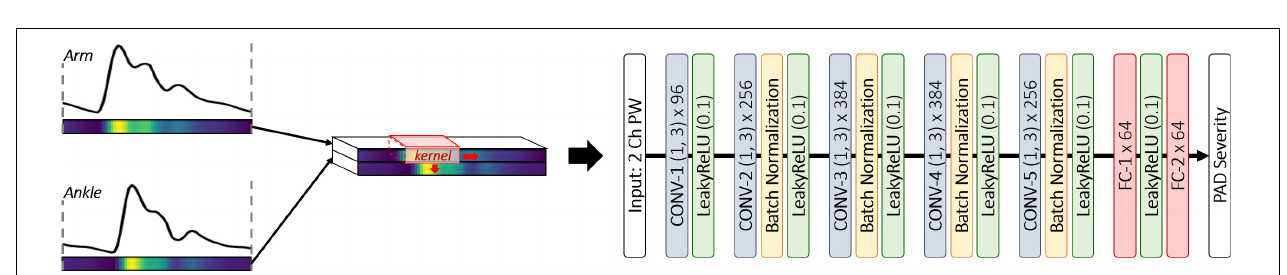
FIGURE 2 | Representative heart blood flow waveform used as input to the multi-branch transmission line (TL) model of arterial hemodynamics associated with virtual patients.